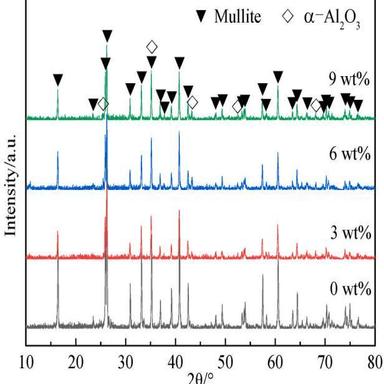
XRD spectra of porous samples prepared with varying contents of AlF3⋅3H2O.